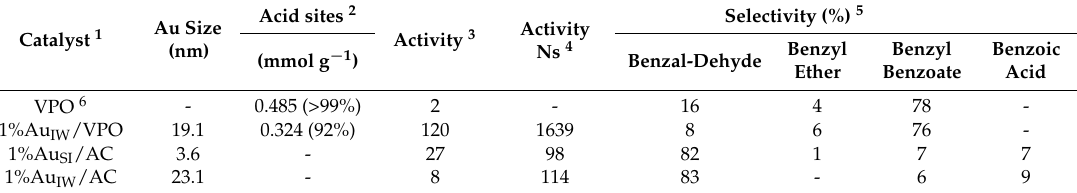
Table 1. Activity and selectivity of Au-based catalysts in the benzyl alcohol